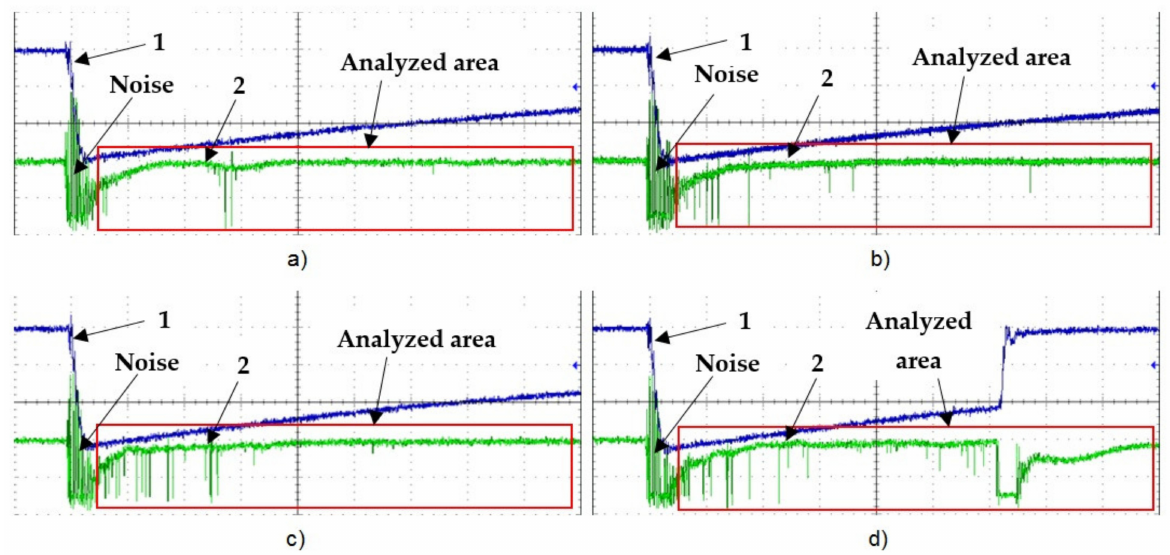
Figure 6. Examples of the oscillograms of successive phases of the step voltage tests at 80 ◦ C. 1, voltage [50 kV/div.]; 2, light [arbitrary units]; time base, 4 µ s/div.: ( a ) 145 kV, ( b ) 150 kV, ( c ) 155 kV, ( d ) 160